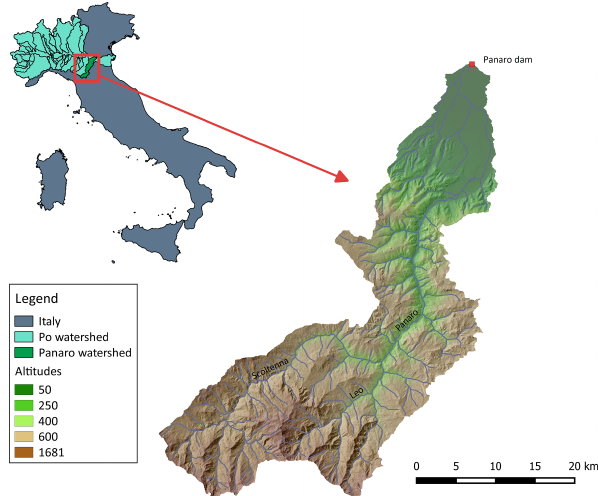
Figure 1. Panaro study